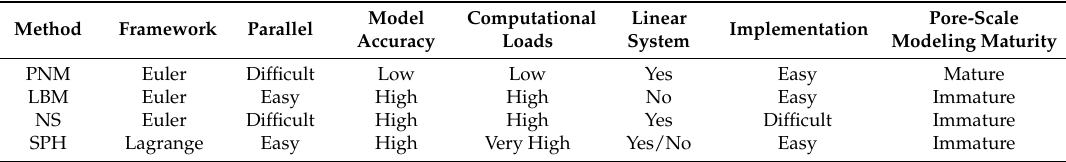
Table 1. Comparisons among different pore-scale simulation